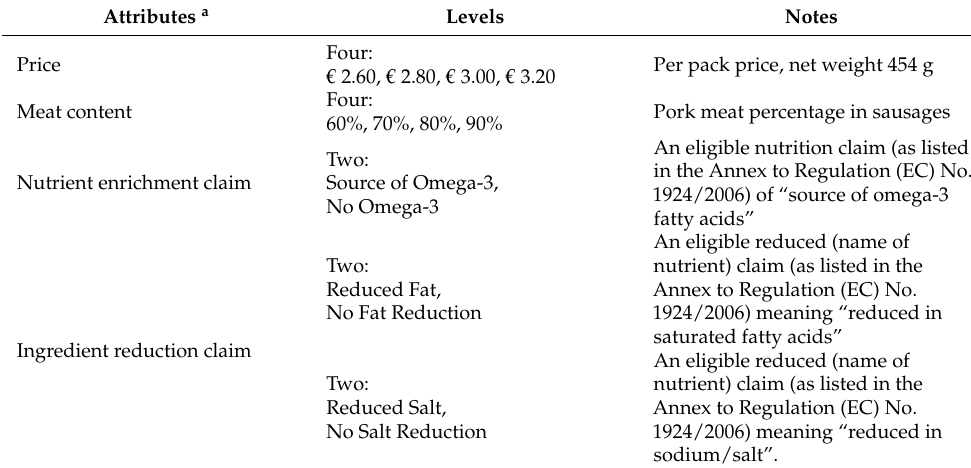
Table 1. Attributes of sausages used in choice experiment